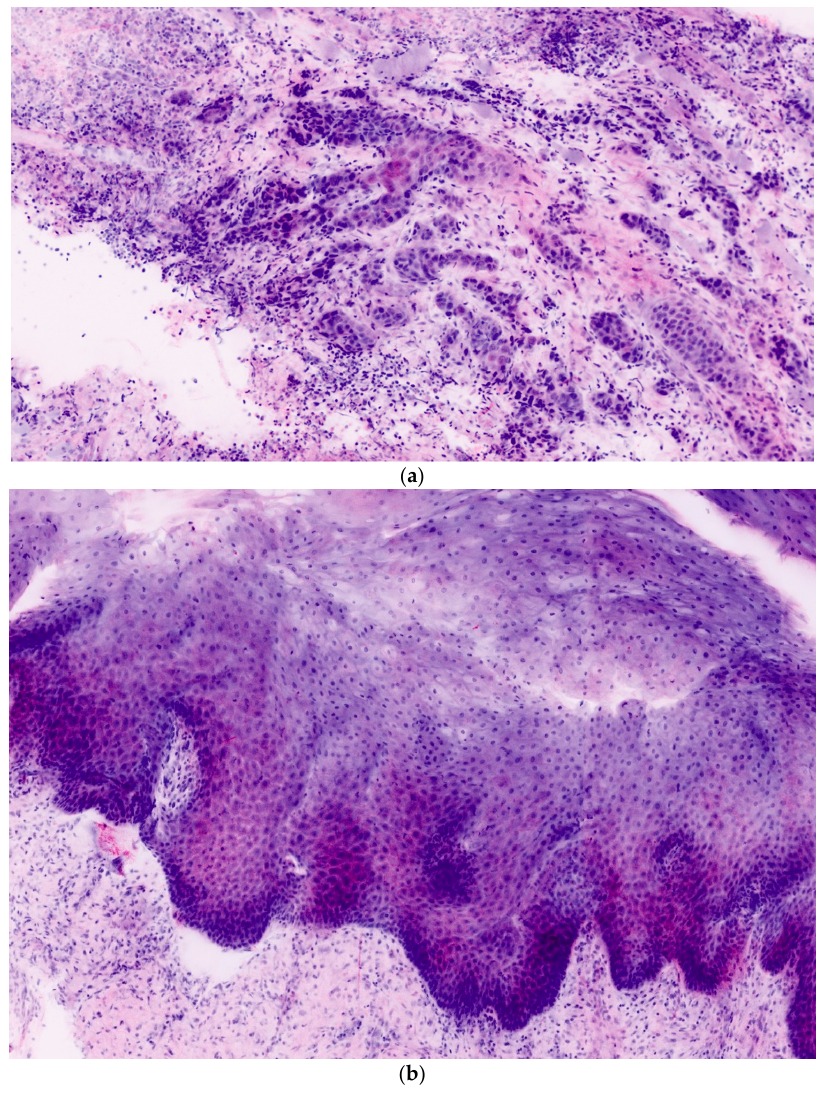
Figure 1. ( a , b ) Examples of ex vivo confocal microscopy mosaics of leukoplakia. Table 3 shows presence or absence of those histological (architectural and cytological) Table 1 summarizes patient demographics and their associated lesion characteristics. features of leukoplakia compared to normal mucosa in ex vivo fluorescence confocal im- ages. Table 1. Patient (N = 22), lesion (N = 27), and confocal submosaic (N = 106)